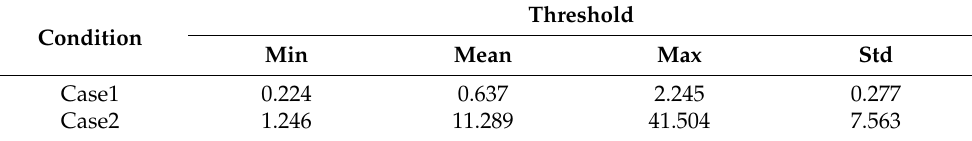
Table 2. statistics of CODM threshold (m).